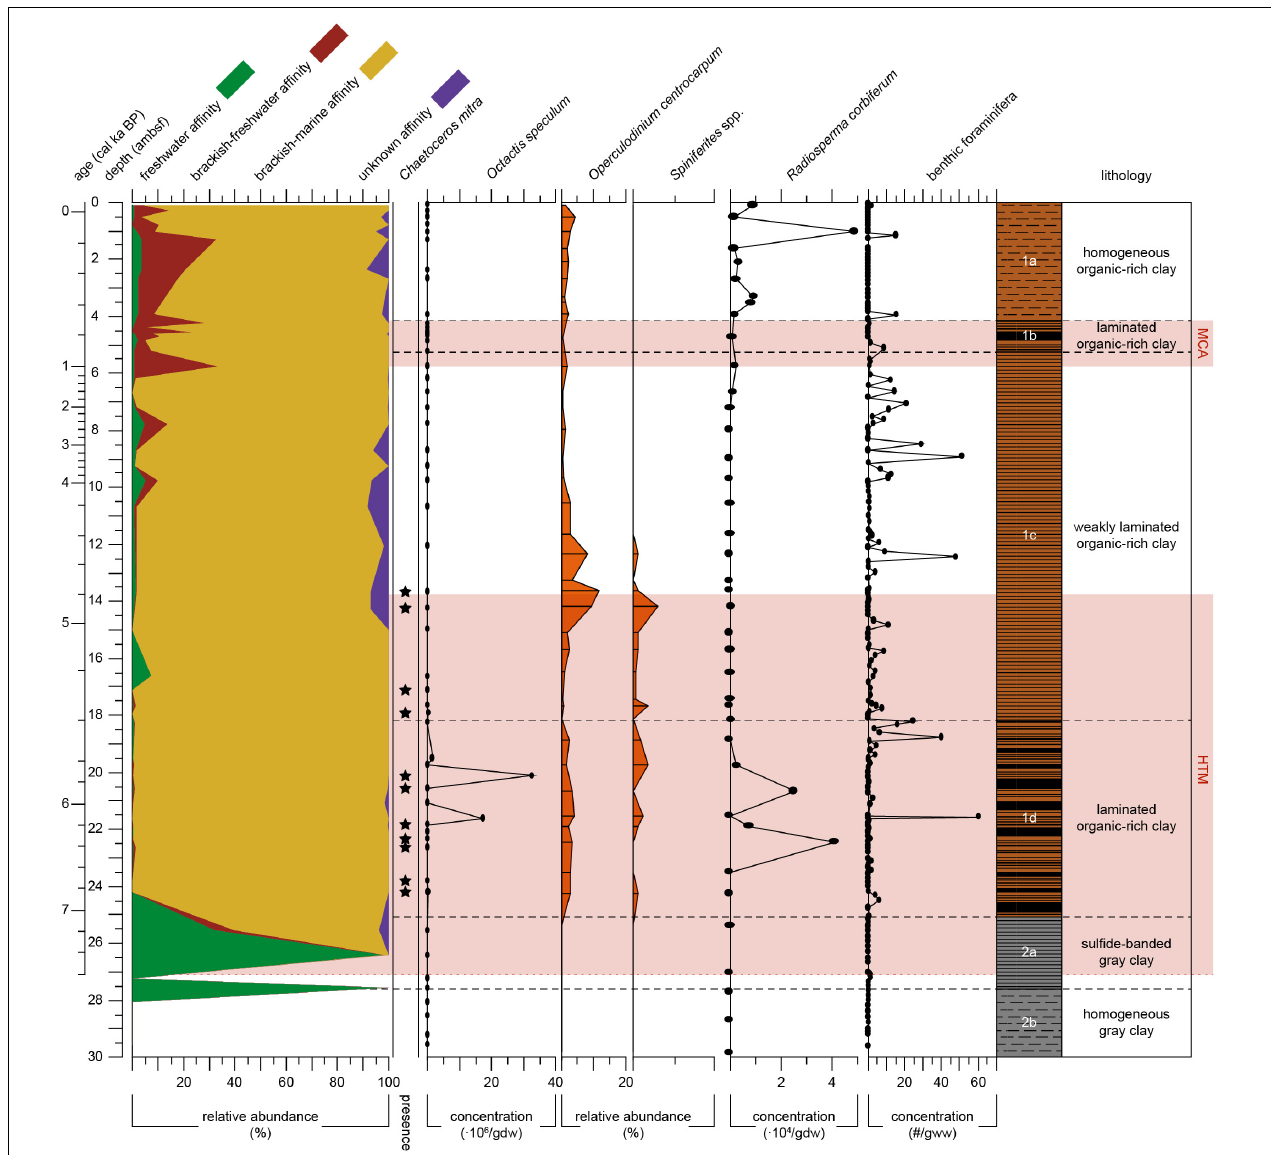
FIGURE 4 | Proxy records for salinity of Integrated Ocean Drilling Program Expedition 347 core M0063D plotted versus depth (adjusted meters below seafloor). Relative abundance of diatom salinity-based affinity groups (i.e., freshwater. brackish-freshwater. brackish-marine and unknown) are plotted as different color-filled areas. Presence of Chaetoceros mitra resting spores are indicated by black dots. Absolute abundance of the silicoflagellate Octatis speculum [ × 10 6 skeletons/gram dry weight (gdw)]. Relative abundances (% related to pollen sum) of dinoflagellate cysts Operculodinium centrocarpum and Spiniferites spp. Absolute abundances of Radiosperma corbiferum ( × 10 4 /gdw). Absolute abundance of benthic foraminifera in number per gram wet weight (gww). The warm climate anomalies Holocene Thermal Maximum (HTM, 8–4.8 cal ka BP, Seppä et al., 2009) and Medieval Climate Anomaly [MCA, 1.0 – 0.7 cal ka BP(MCA, 1.0 – 0.7 cal ka BP, Mann et al., 2009)] are represented by the light red areas. Lithology and sedimentological units are obtained from Andrén et al.